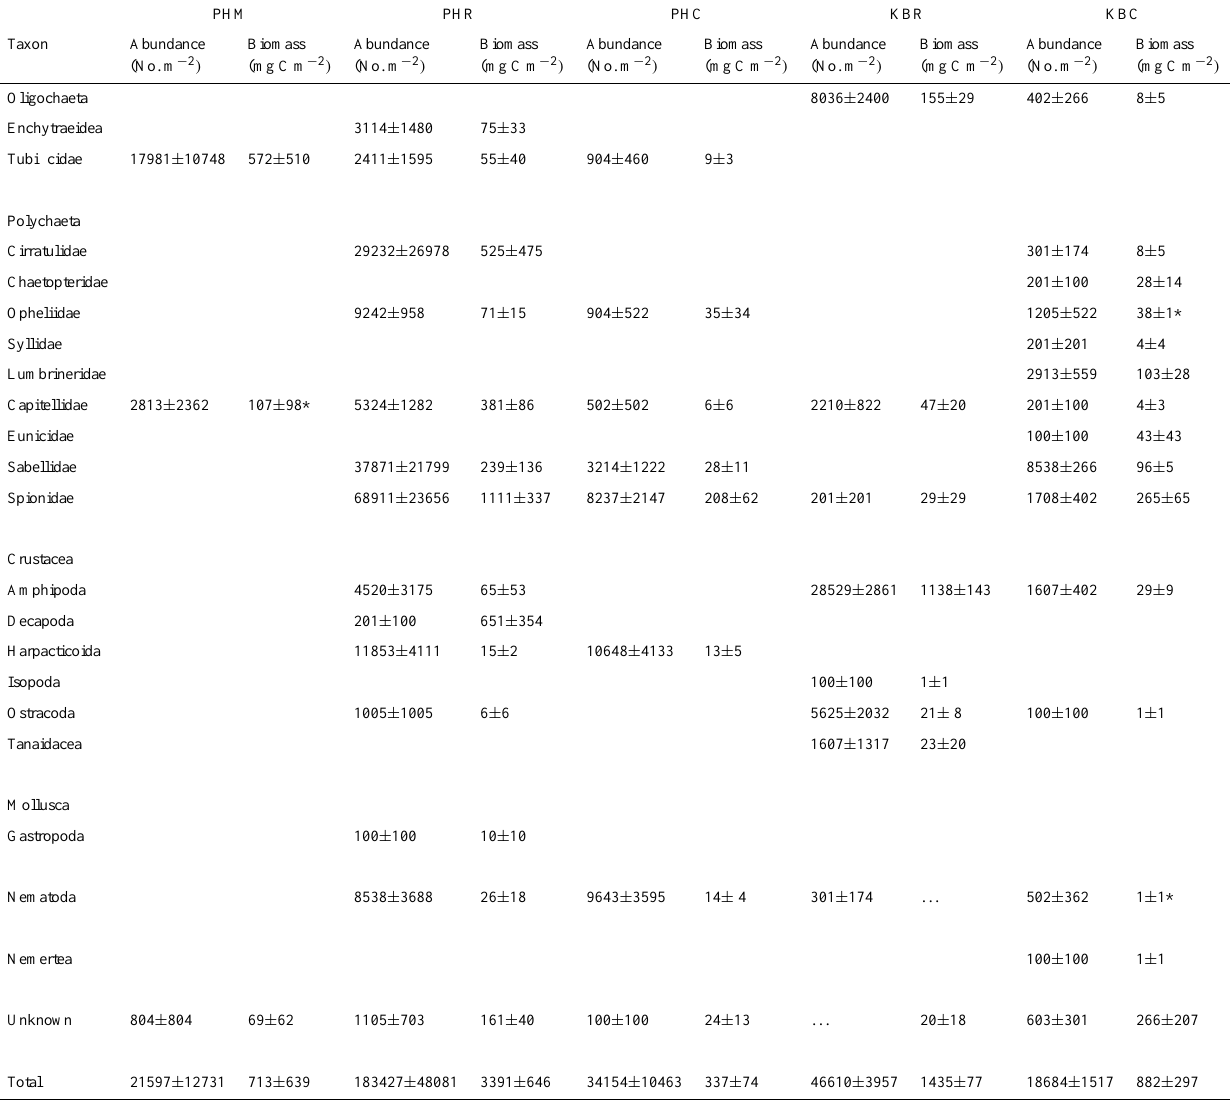
Table 2. Mean abundance (Number m − 2 ± 1SE, n = 3) and biomass (mg C m − 2 ± 1SE, n = 3) estimates of major macrofauna taxa from sediment cores collected from all 5 sites. Star ( ∗ ) denotes mean ± range of 2 samples when a single replicate sample was lost prior